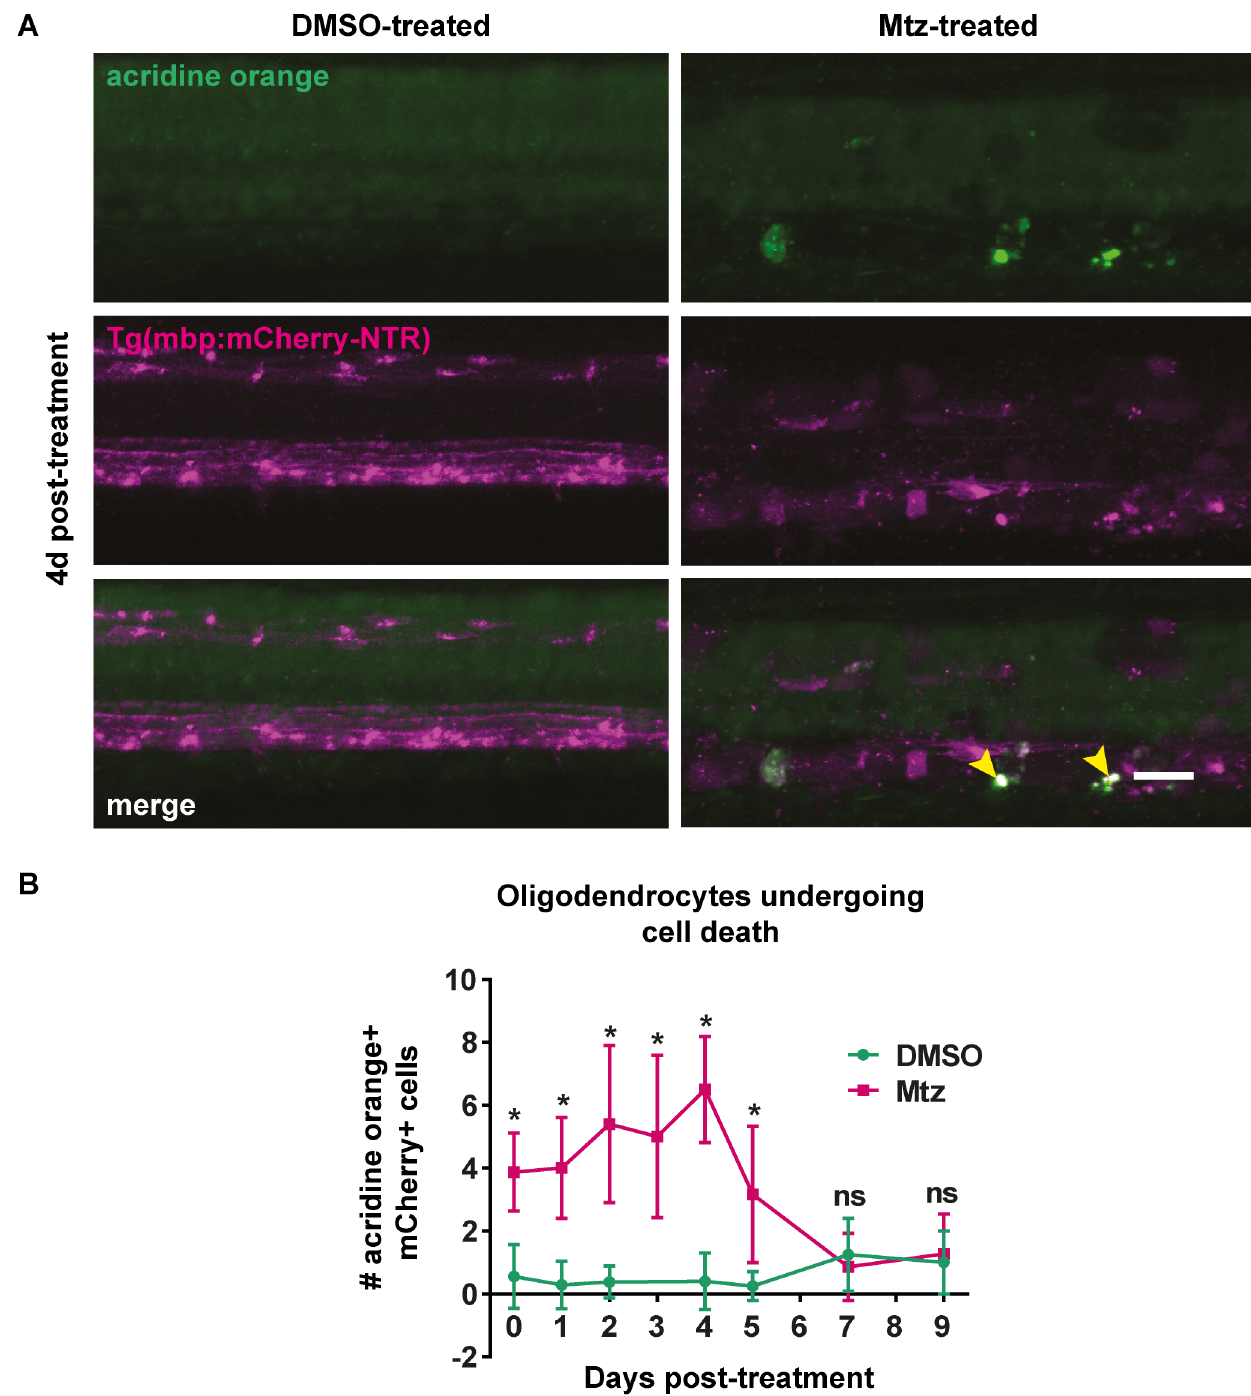
Fig 4. Acridine orange staining revealsoligodendrocytes undergoing cell death following treatment with Mtz. A . Representative images of spinal cords of DMSO- or Mtz-treated Tg(mbp:mCherry-NTR) larvae at 4dpt. Acridineorangelabels cells undergoingcell death in green. In Mtz-treated animalsseveral bright green puncta can be seen, and these colocalisewith mCherry (yellow arrowheads). B . Quantification of cells that are positive for both mCherry and acridine orange, per four-somite stretch of spinal cord. At 0dpt, control mean: 0.56 ± 1.01 vs treated: 3.88 ± 1.25, p < 0.0001. The numberof AO+ cells peaks at 4dpt, when the mean in controls was: 0.4 ± 0.89, vs treated: 6.5 ± 1.69, p < 0.0001. This then reducedso that at 7dpt, controls: 1.25 ± 1.16 vs treated: 0.86 ± 1.07, p = 0.510. All significances were obtained using multiplet tests per row (Holm-Sidak method). n = no less than 8. Scale bar: 20 μ m.